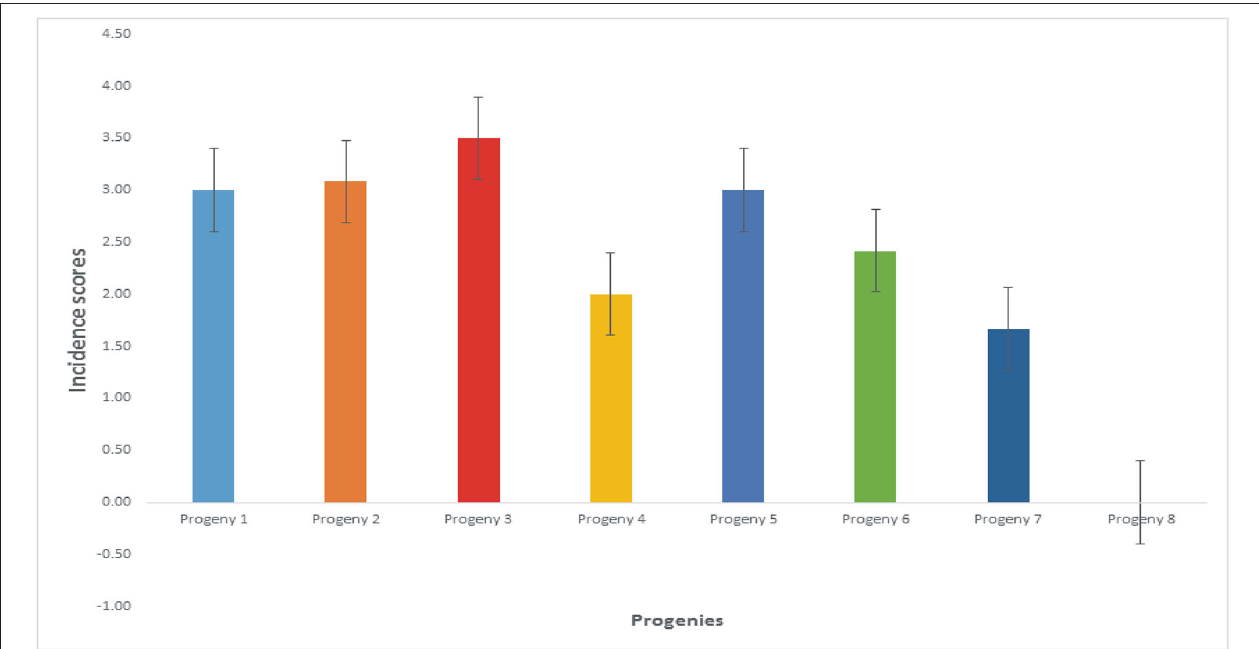
FIGURE 4 | Mean incidence scores on oil palm genotypes as a result of the effects of Fusarium strains.